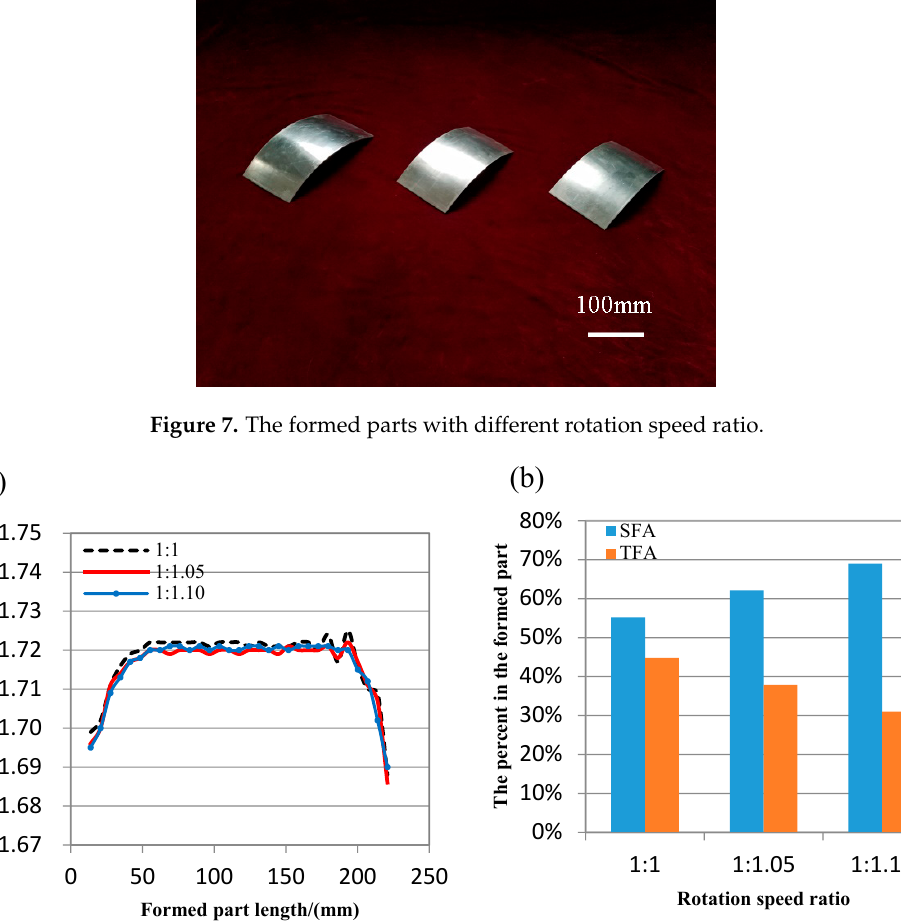
Figure 8. The formed part with different rotation speed ratio ( a ) thickness distribution ( b ) the percent of effective area.